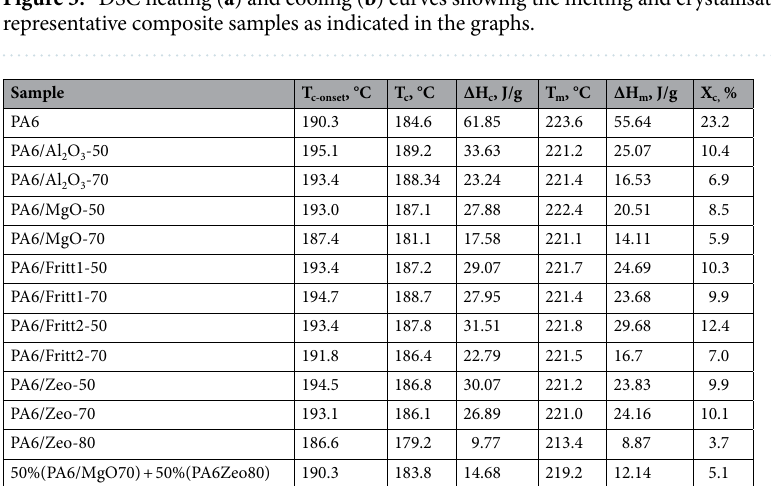
Table 4. Parameters obtained from DSC heating and cooling